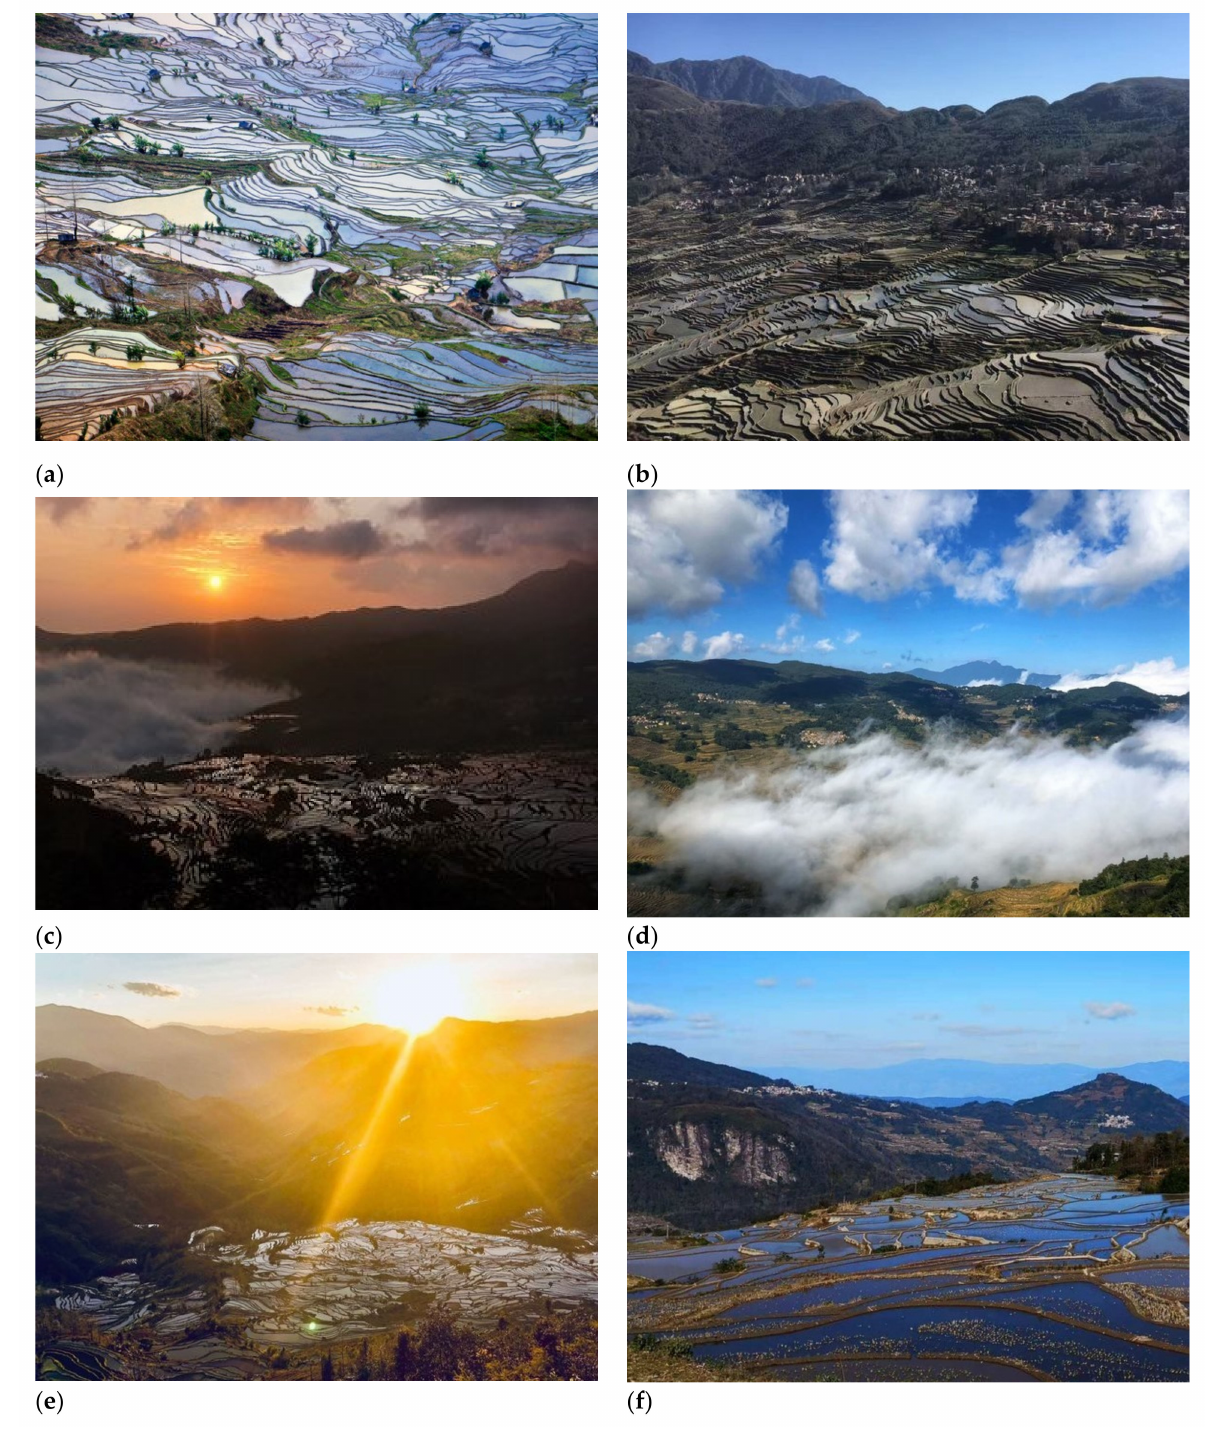
Figure 6. Examples of image composition patterns in tourist photography: ( a ) layer pattern; ( b ) viewing deck panorama; ( c ) sunrise; ( d ) terraced fields amid fog/sea of clouds; ( e ) sunset; ( f ) blue